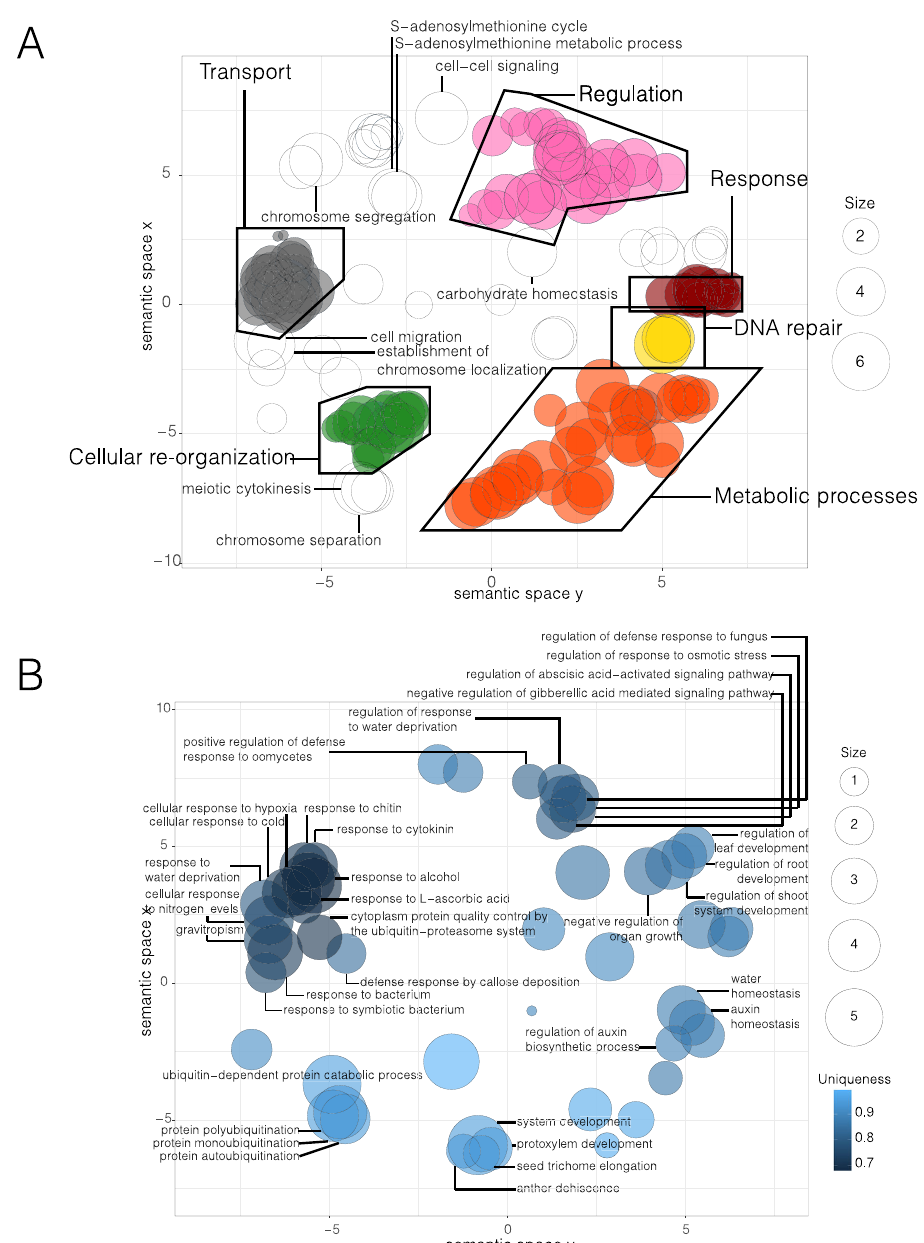
Fig. 5 Positive selection and gene-family expansion across the Scalesia atractyloides genome. A GO term enrichment of the genes under selection across the genome. GO terms assigned to at least four genes are labelled. Size refers to the number of genes associated with a particular GO term. B GO term enrichment of the genes belonging to expanded gene families across the genome according to a CAFE analysis. Only GOs within a group of three or more overlapping circles are included. Uniqueness measures the degree to which a particular GO term is distinct relative to the whole